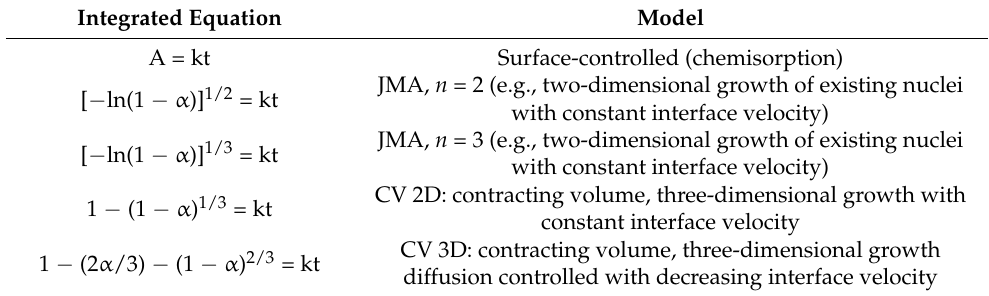
Table 4. Equation for kinetic models used for absorption and desorption kinetics of this study. Integrated Equation Model A = kt Surface-controlled (chemisorption) JMA, n = 2 (e.g., two-dimensional growth of existing nuclei [ − ln(1 − α )] 1/2 = kt with constant interface velocity) with constant interface velocity) CV 2D: contracting volume, three-dimensional growth with constant interface velocity CV 3D: contracting volume, three-dimensional growth diffusion controlled with decreasing interface